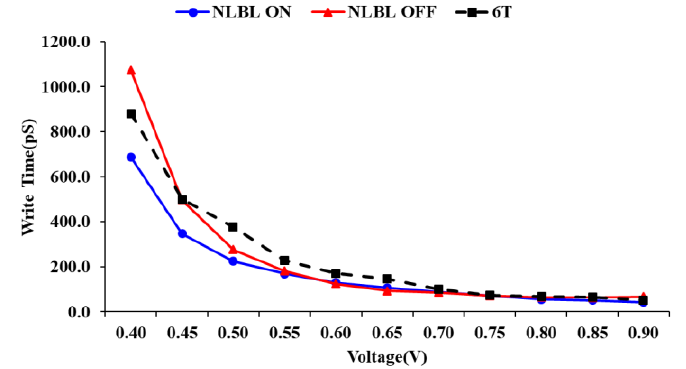
Figure 7. Write ability comparison at different operating voltages.